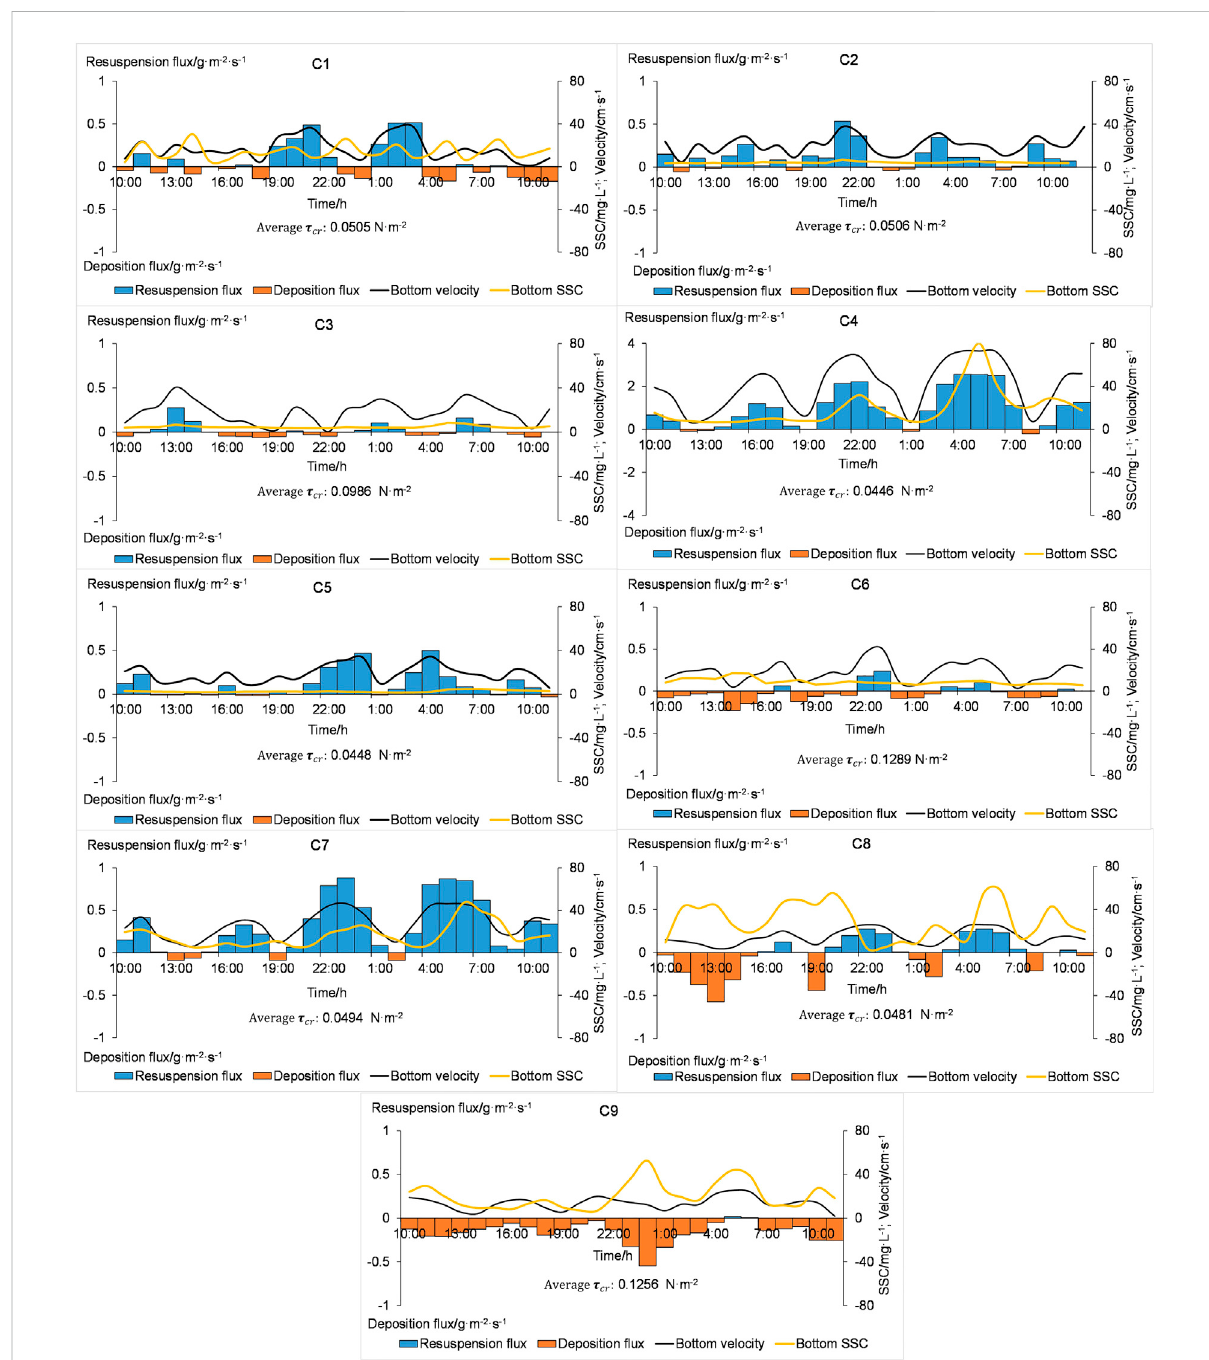
FIGURE 11 Resuspension fl ux (blue rectangle) and deposition (orange rectangle) fl ux at each station during the spring tide. Black line represents bottom fl ow velocity. Yellow line represents bottom